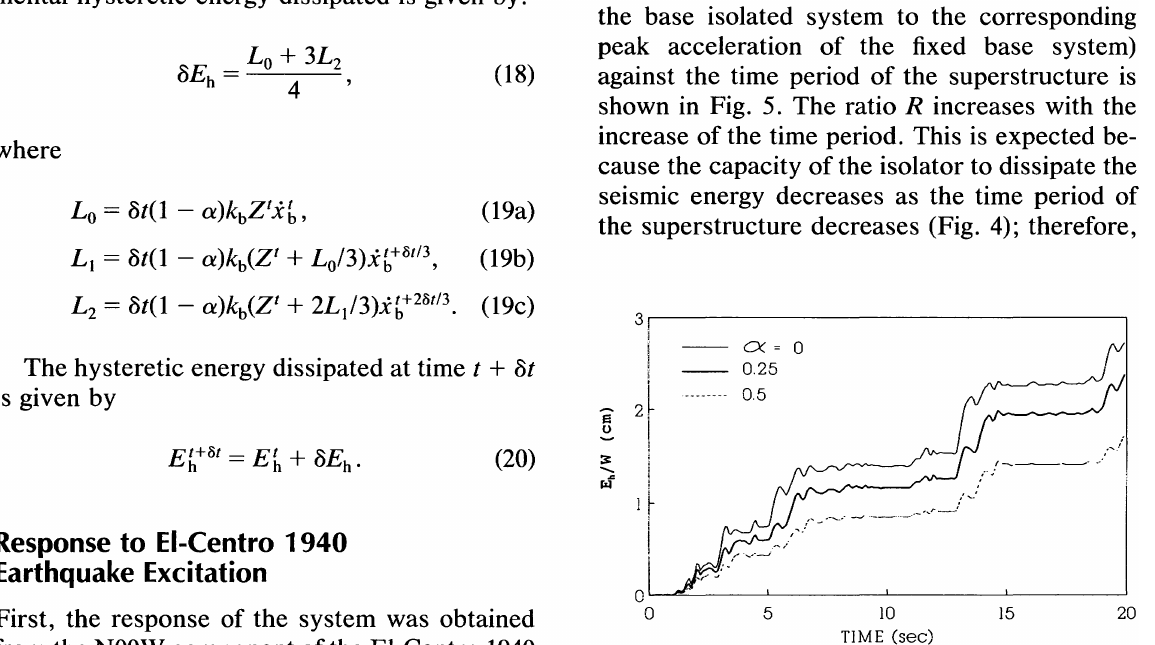
FIGURE 3 Time variation hysteretic energy dissi pated for EI-Centro earthquake: T = 1 s, mb1m = 1.5, and QyfW =